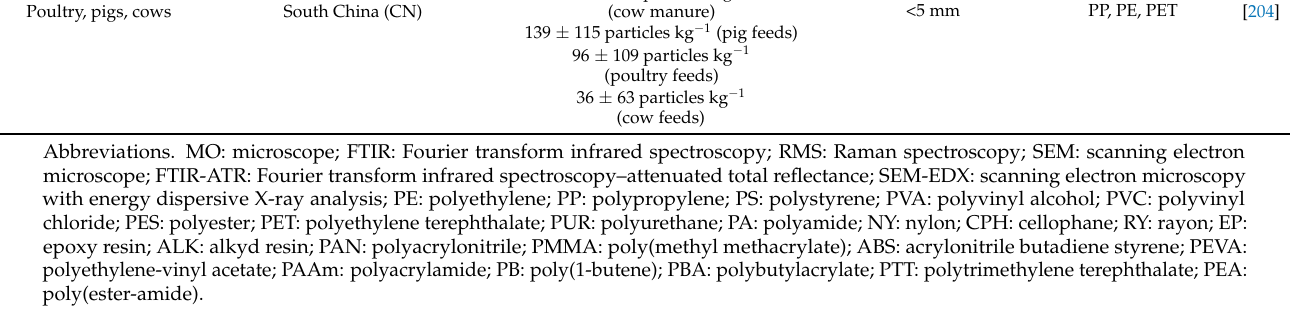
Table 2. Estimated intake of microplastics through inhalation, food and beverages, and packaging.